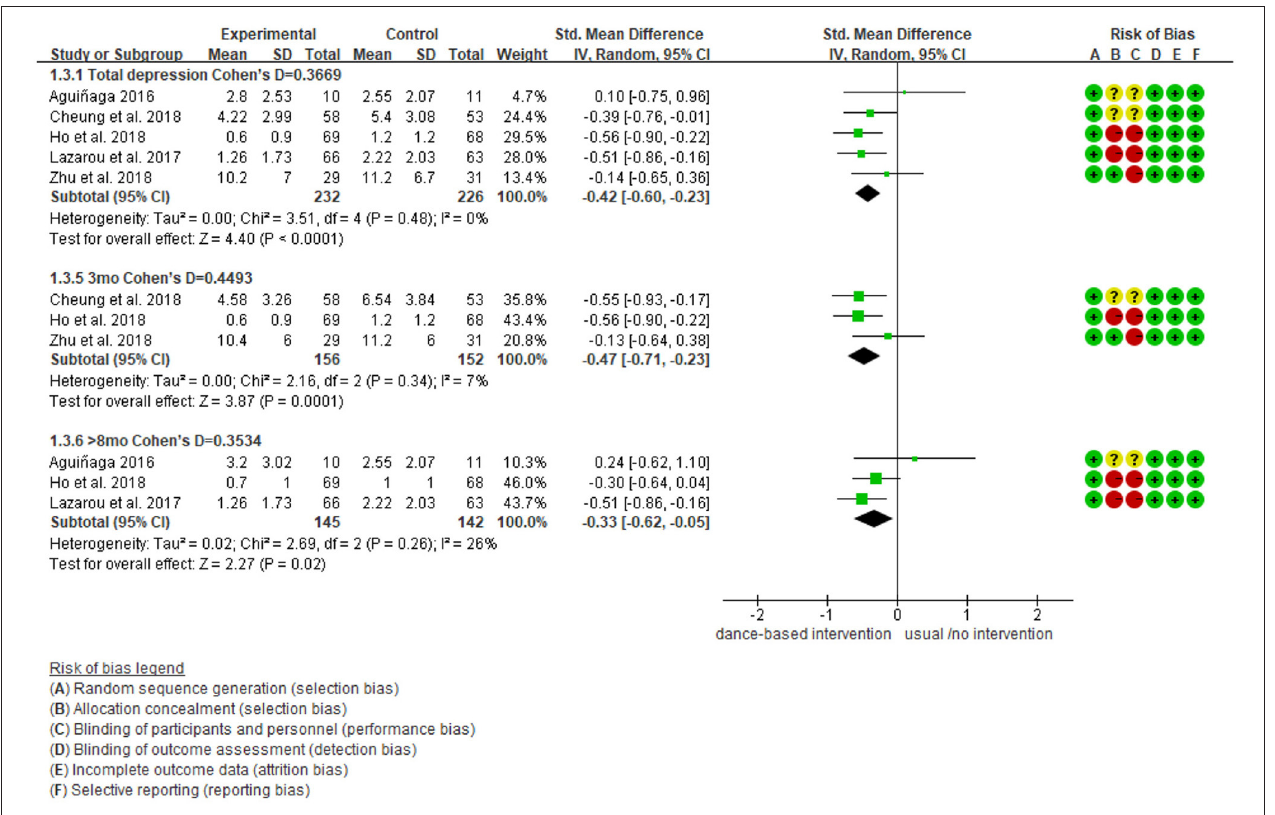
FIGURE 5 | Subgroup analyses of the intervention group vs. the control group on depression rating scores: Intervention